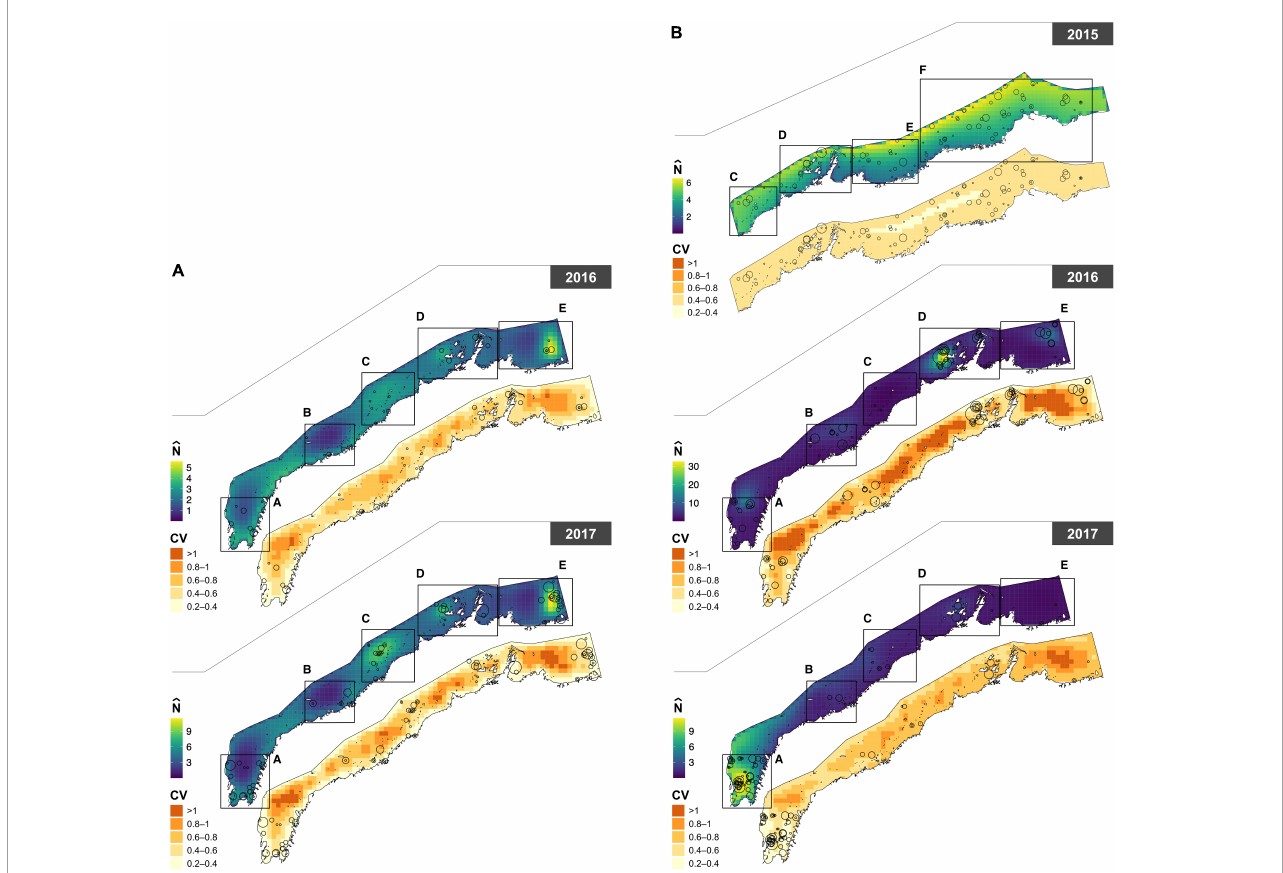
FIGURE3 Paired maps of predicted abundance ( ˆ N ) for (A) humpback ( Sousa saluhensis ) and (B) bottlenose ( Tursiops aduncus ) dolphins, with associated uncertainty (represented as the coefficient of variation, CV). Circles represent sightings of dolphin groups; their size is proportional to group size (see Figure 1 for